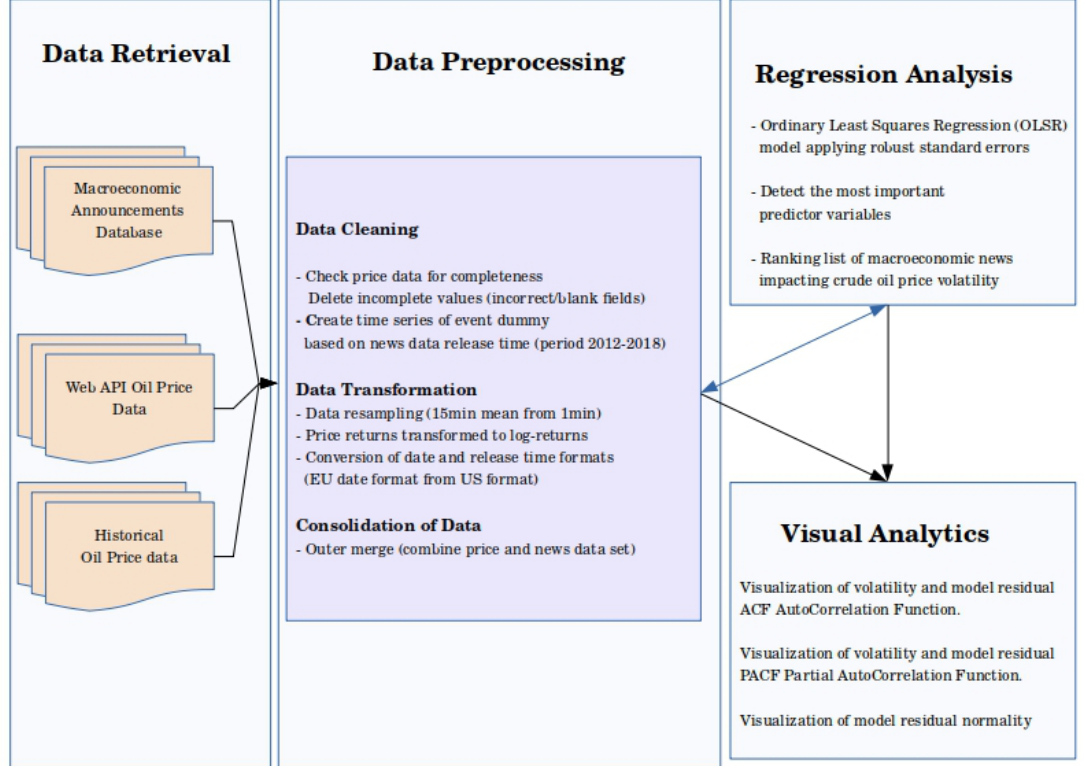
Figure 1: Overview of the implemented data mining techniques showing the summarized principles of the data science workflow.Source: Faseli,